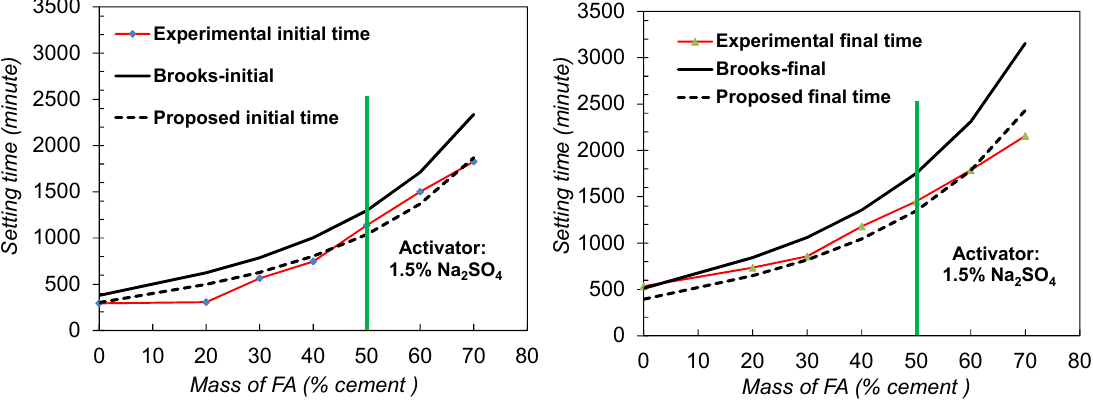
Figure 14. Predictions of Brooks and proposed models for FACs with 1.5% of Na 2 SO 4.